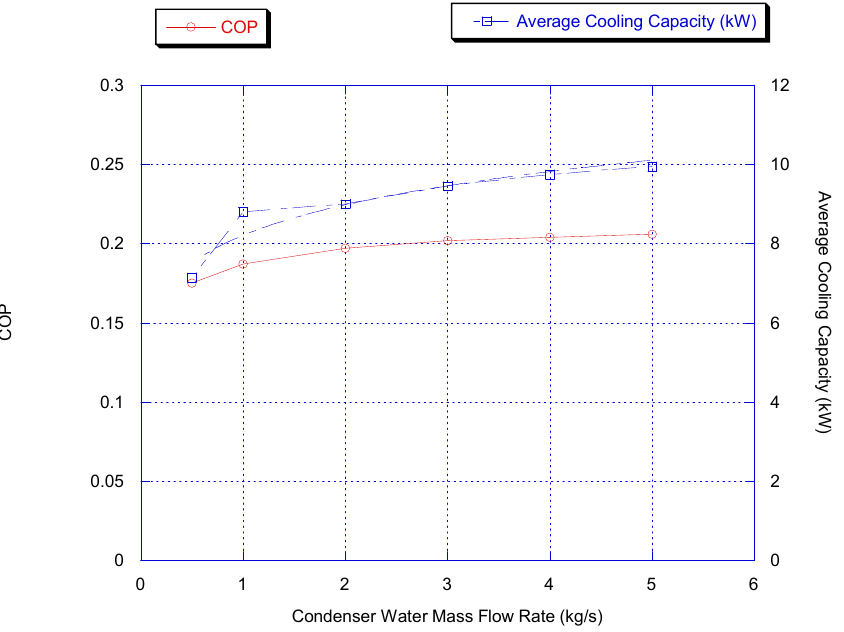
Figure 10. Effect of condenser water flow rate on chiller average cooling capacity and COP (results are at chiller nominal operating conditions, shown in Appendix B).